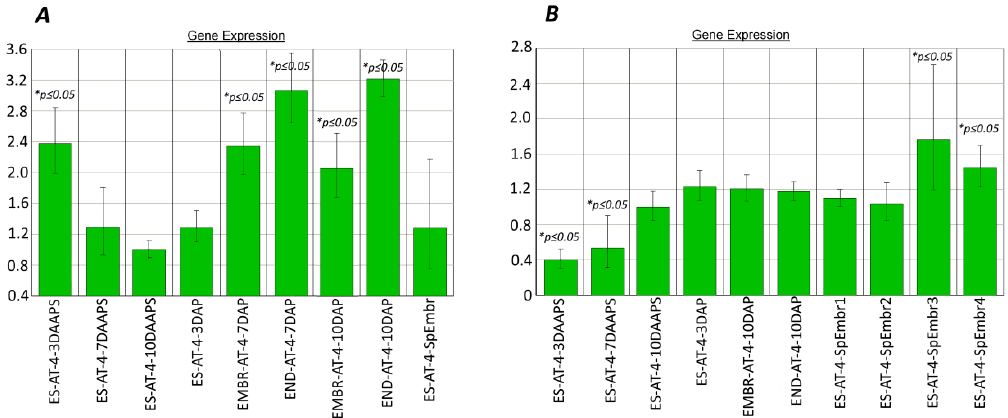
Figure 5. fie1 ( A ) and fie2 ( B ) expression in ESs with parthenogenic proembryos* (10 DAAPS) and in unpollinated ESs (7 and 10 DAAPS). Control: ESs at 10 DAAPS. *ES-AT-4-7-10DAAPS: in one biological experiment, each sample consisted of 12 unpollinated ESs. Data are from two independent biological experiments.